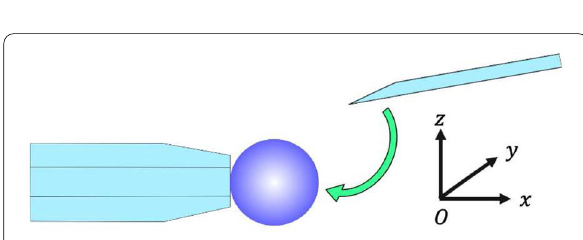
Fig. 18 Experimental task to verify the operation